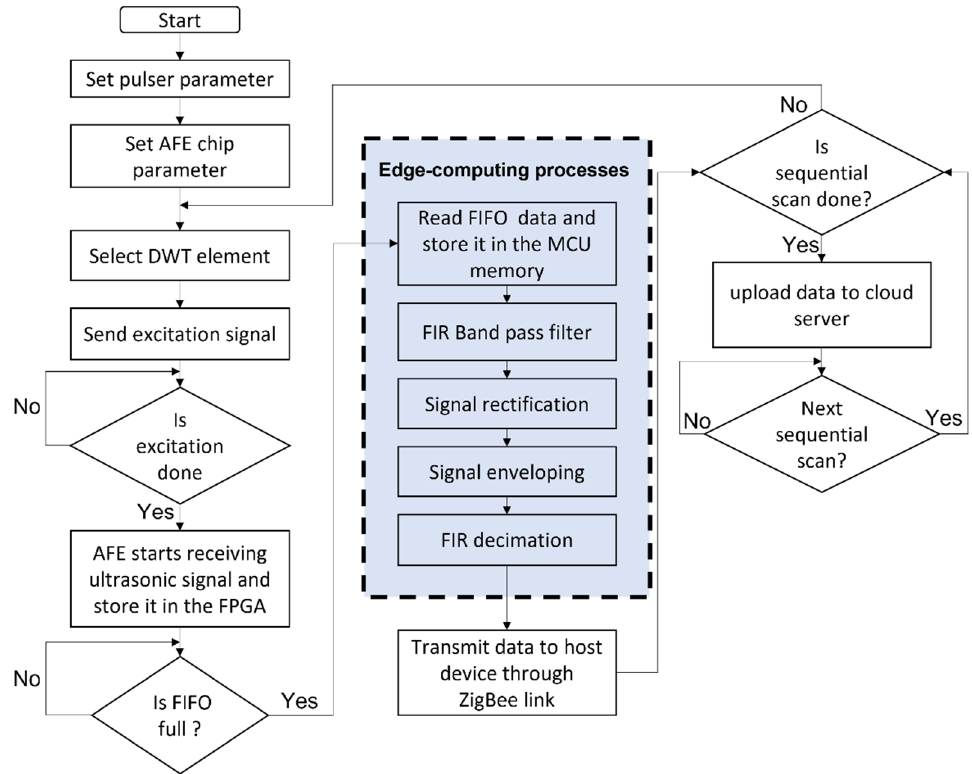
Figure 5. Flow chart of the ultrasonic signal collection, processing, and wireless transmission process, describing the functionality of the developed active ultrasonic SHM edge system, including edge-computing processes.